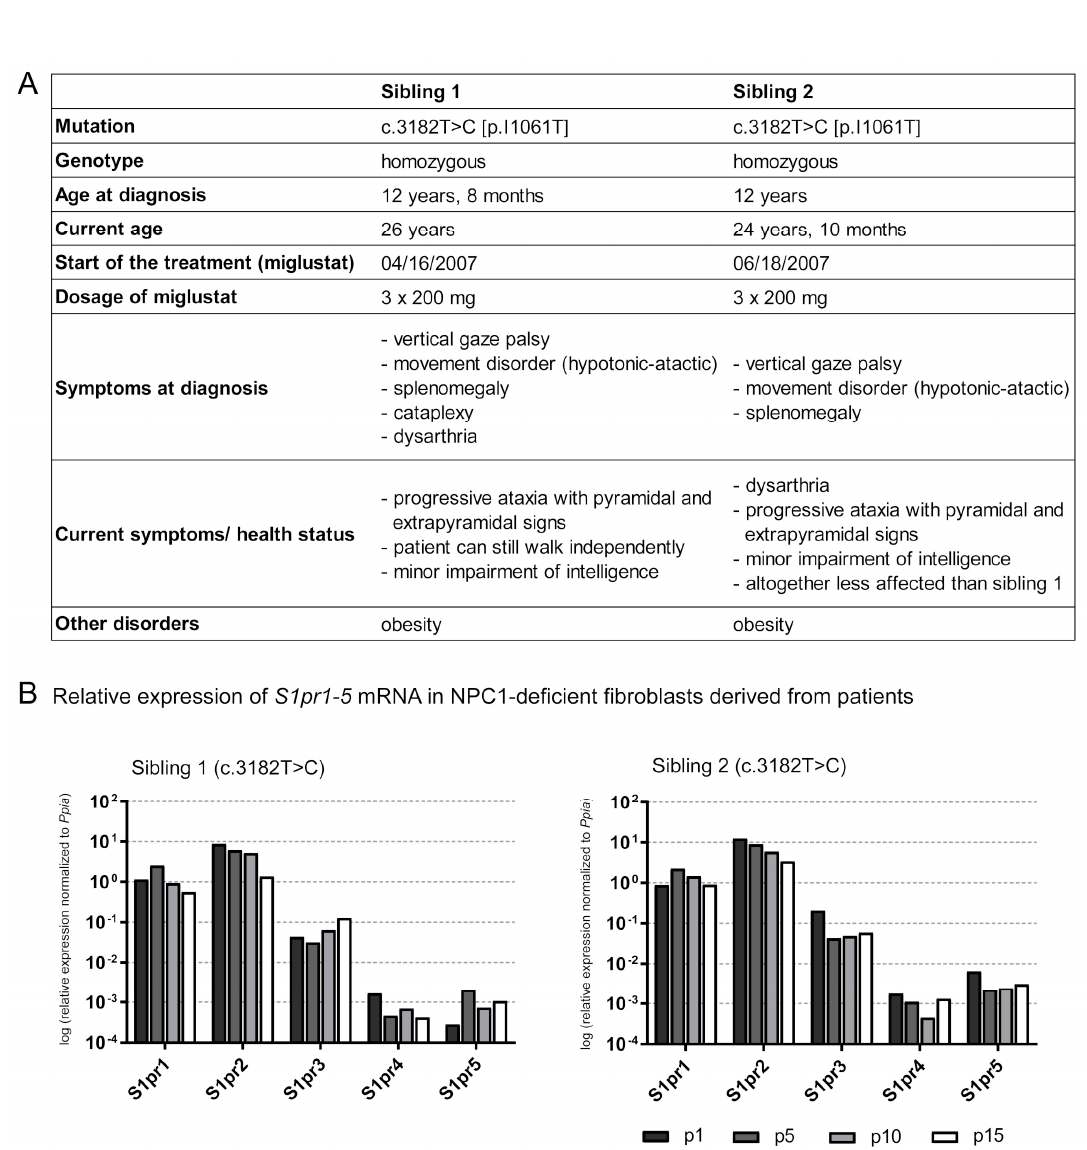
Figure 6. Characterization of the NPC1 disease of two siblings carrying the homozygous mutation c.3182 T > C ( A ). Both patients show neurological manifestations, such as ataxia, as well as visceral symptoms (splenomegaly). Fibroblasts of both siblings were used for further experiments: qRT-PCR was performed ( B ), suggesting that multiple washing steps could change the miglustat concentration in fibroblasts. S1pr1-5 mRNA expression in NPC1-deficient fibroblasts were analyzed over 15 splitting procedures (p). Comparing the expression at p15 to that at p1, sibling 1 tended to reduce S1pr1 , S1pr2 and S1pr4 mRNA and increased S1pr3 and S1pr5 mRNA level. Sibling 2 reveals similar changes in S1pr1 and S1pr2 expression. Comparing the expression of p15 to p1, however, sibling 2 also showed decreased expression of S1pr3 , S1pr4 and S1pr5 . Interestingly, S1pr5 expression level was clearly decreased in sibling 1, the symptomatically more affected patient, compared to sibling 2. N = 1 technical control, normalized to Ppia . p1, p5, p10, p15 = passaging number of fibroblasts.